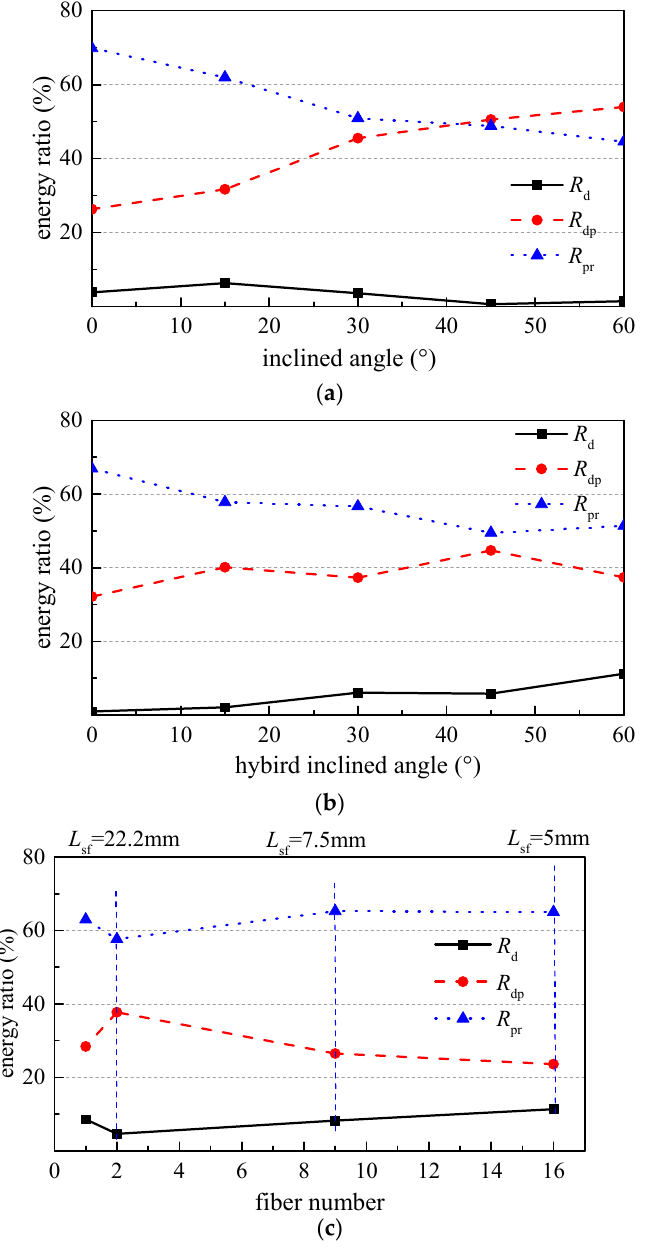
Figure 9. Influence of various factors on the bond energy ratios. ( a ) Series IA, ( b ) Series HIA and ( c ) Series NA.